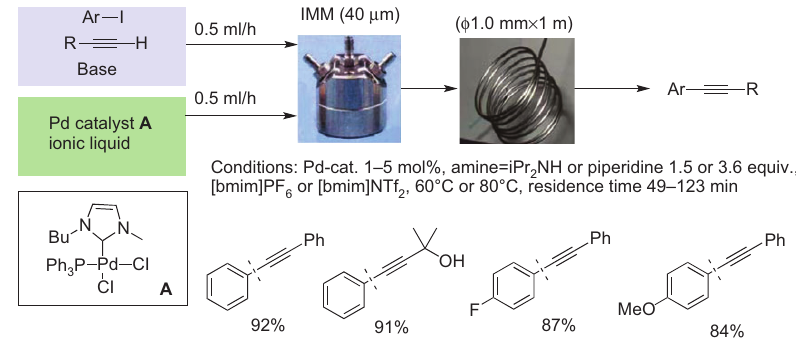
Scheme 3 Copper-free Sonogashira coupling reaction using a flow microreactor.